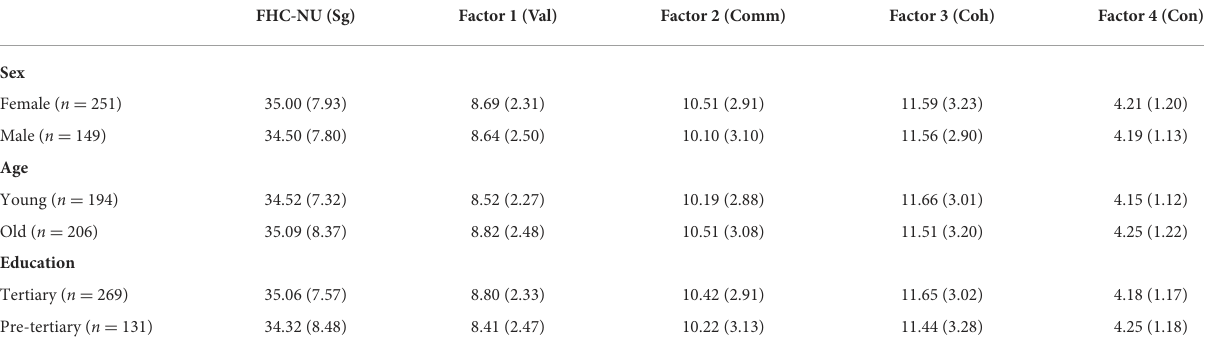
TABLE 12 Demographic group means and standard deviations for FHC-NU (Sg) scale and factor levels.